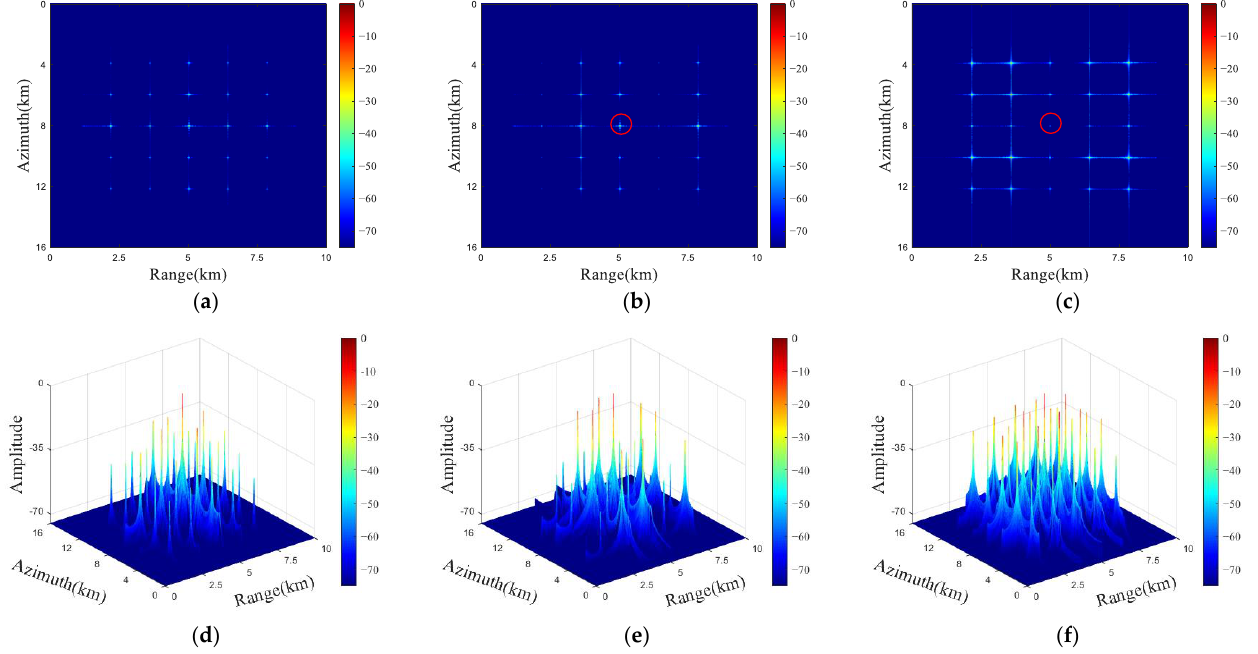
Figure 10. Simulation results of point targets with 𝑀 r = 𝑀 a = 3 (The real target is inside the red circle). ( a ) The results with intra-pulse and inter-pulse encoding without amplitude encoding. ( b ) The result with amplitude coding values of 1, 0.1, and 1. ( c ) The result with amplitude coding values of 0.1, 5, and 0.22. ( d – f ) The 3D imaging results of ( a ), ( b ), and ( c ), respectively. Table 2. Peak value and position of false